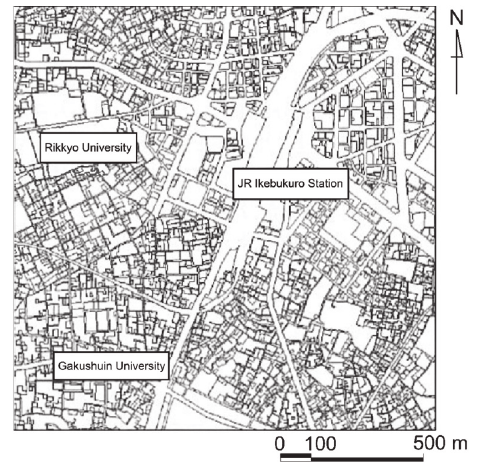
Figure 4 . Study area. Figure 5 . Information-gain rate.